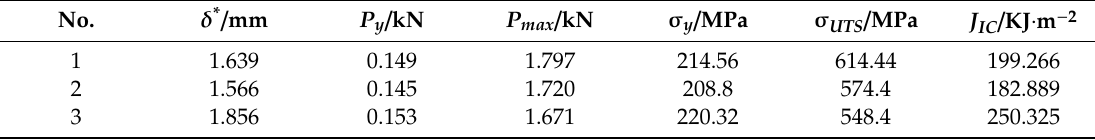
Table 5. The J IC data from our calculations. Figure 6. The L-D curve of the SPT of the three joints.